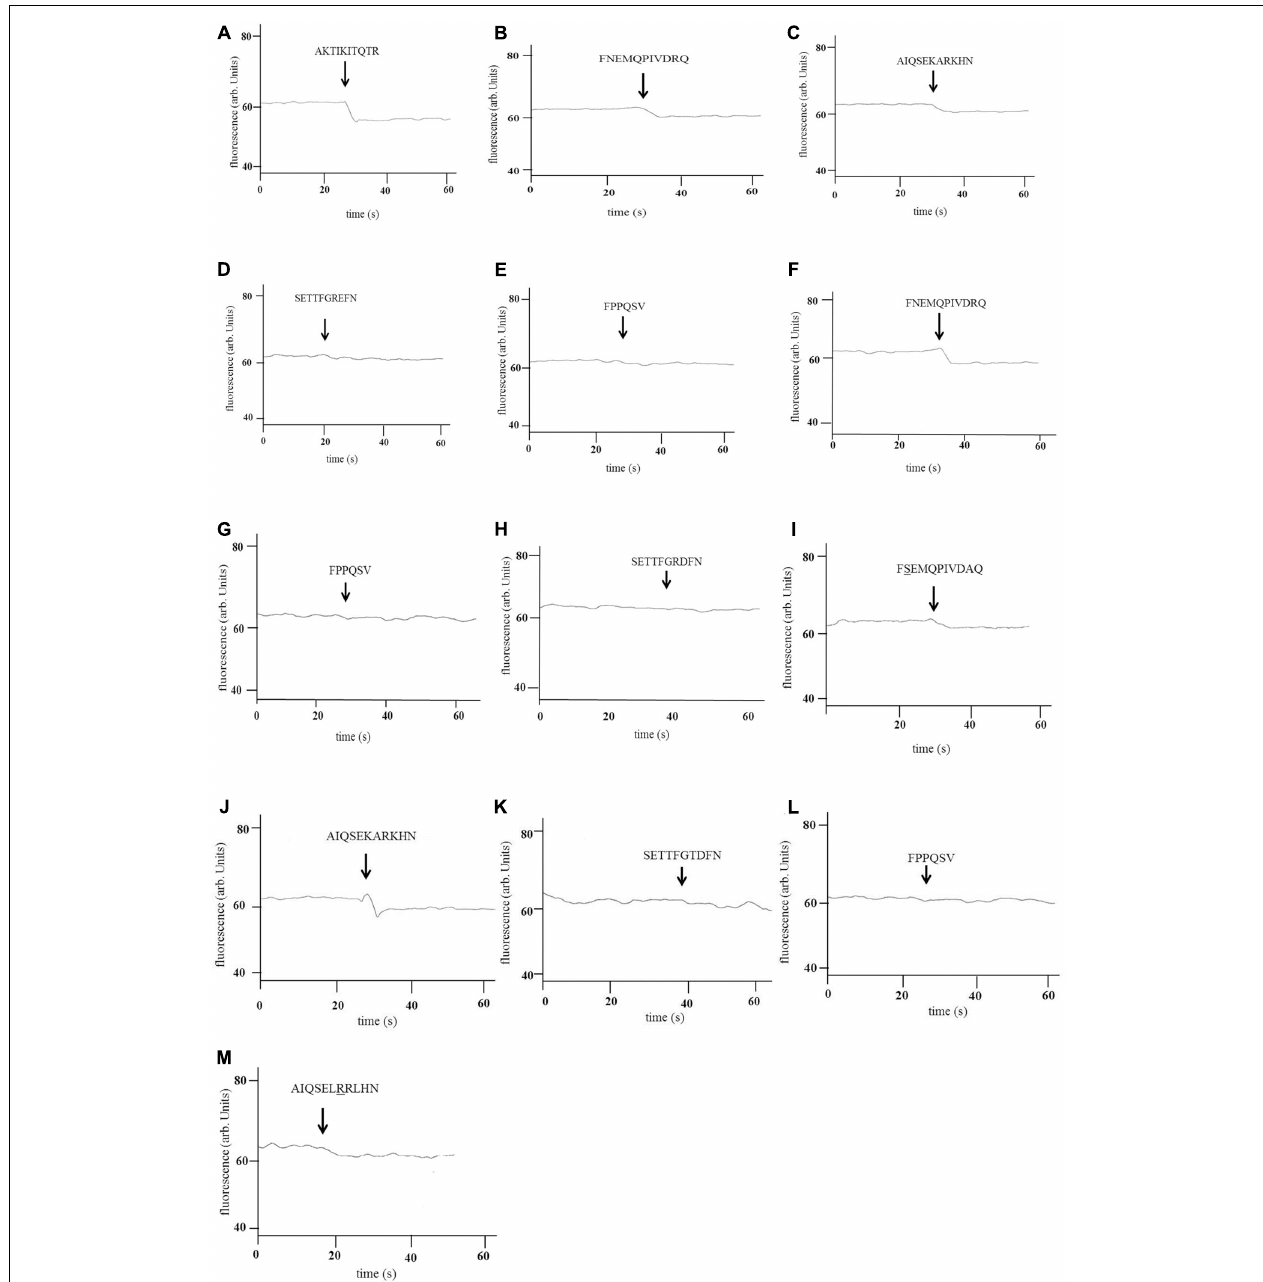
FIGURE 2 | Binding of AmiA, AliA, and AliB to their peptide ligands. Binding of recombinant AmiA (A–E) , AliA (F–I) , and AliB (J–M) to the peptides shown was determined by intrinsic tryptophan fluorescence-binding assay. A drop in fluorescence indicates binding. Peptide sequences are indicated above the arrows marking the point of their addition to the protein. A representative of three independent experiments, performed on different days, is shown. AmiA bound its predicted ligand (A) but also the ligands of AliA (B) and AliB (C) but not the ligands of AliB-like ORF 1 (D) and AliB-like ORF 2 (E) which acted as negative controls. AliA also bound its predicted ligand (F) but not the negative controls (G,H) . There was also a drop in fluorescence upon exposure to its ligand with one amino acid change (underlined) (I) although this was less evident than in (F) . AliB also bound its predicted ligand (J) but neither of the negative controls (K,L) or to a great extent to its ligand with one amino acid change (underlined) (M) .